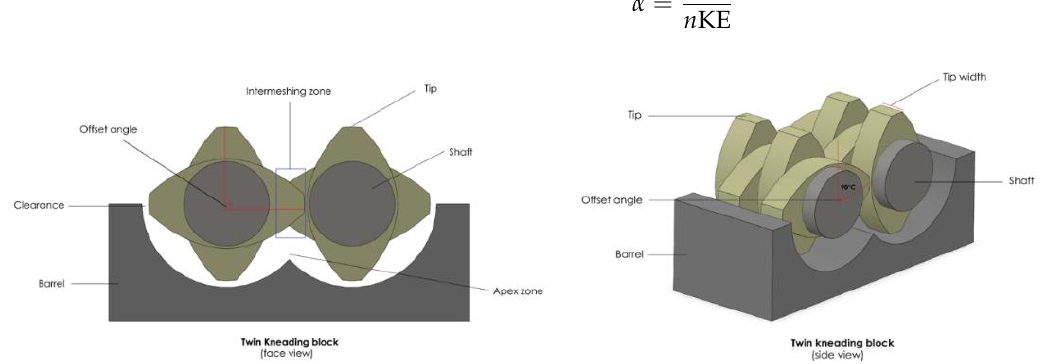
Figure 8. Kneading blocks (front-facing and lateral